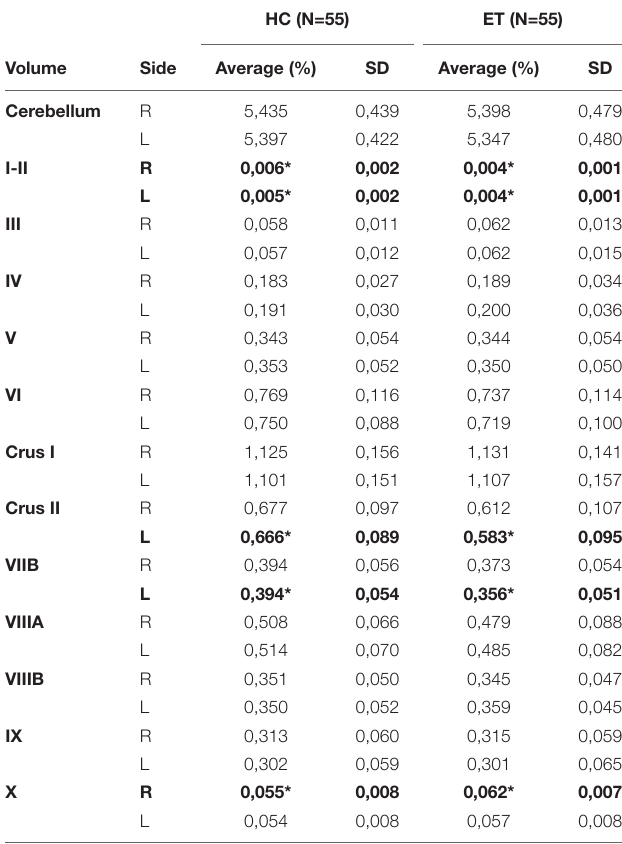
TABLE 2 | Volumes of cerebellar lobules I–X in healthy controls (HCs) and in patients with essential tremor (ET) normalized to total brain tissue (reported as